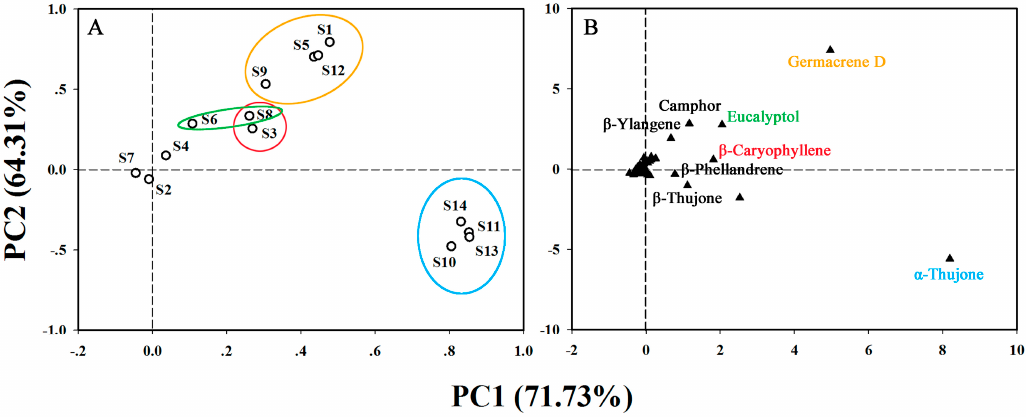
Figure 4. Principal component analysis of 14 samples based on PC1 and PC2 scores. ( A ) Loading plot of samples, and sample numbers are the same as in Table 2; and ( B ) loading plot of terpenoid compounds.